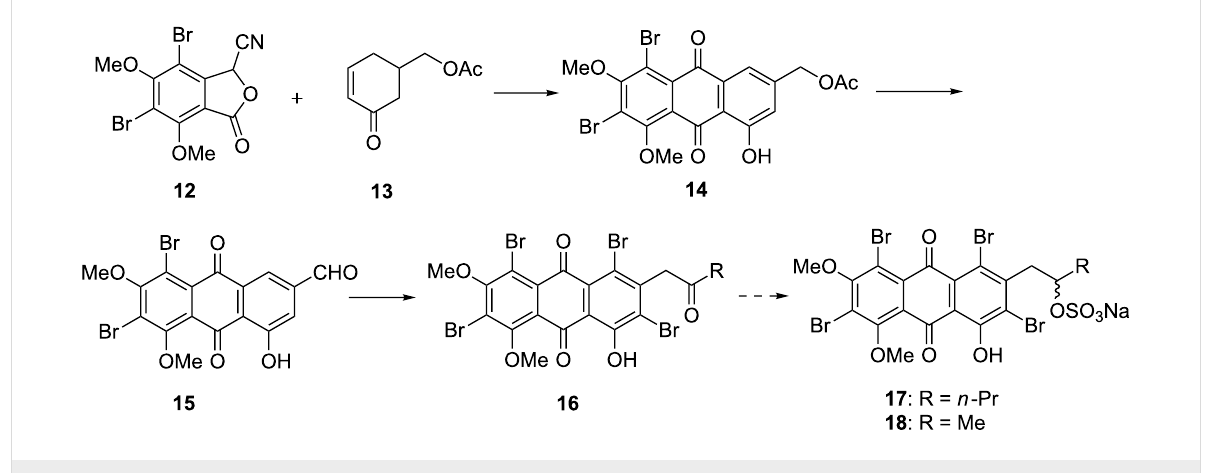
Scheme 1: Initially proposed synthetic scheme for proisocrinins 6 – 11